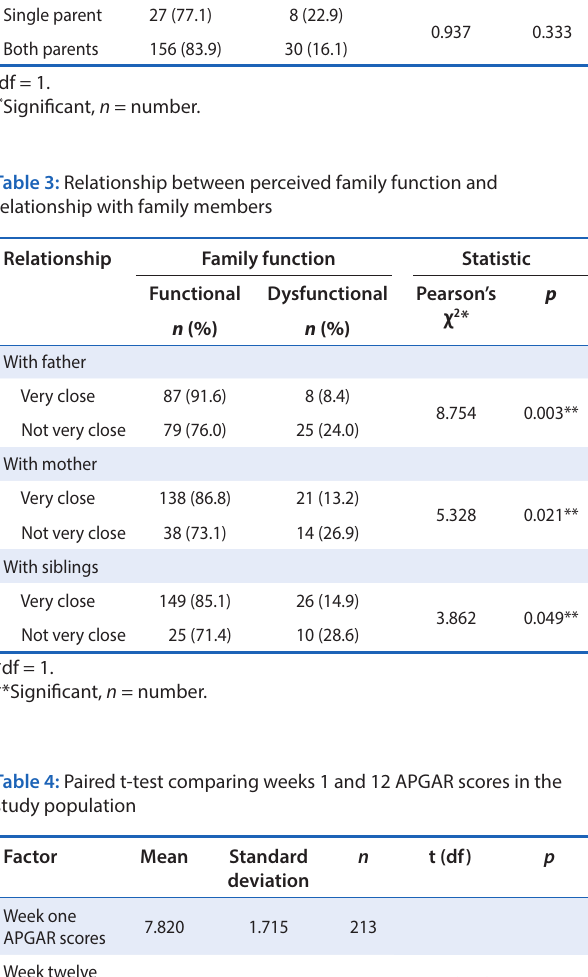
* df = 1. ** Significant, n = number.